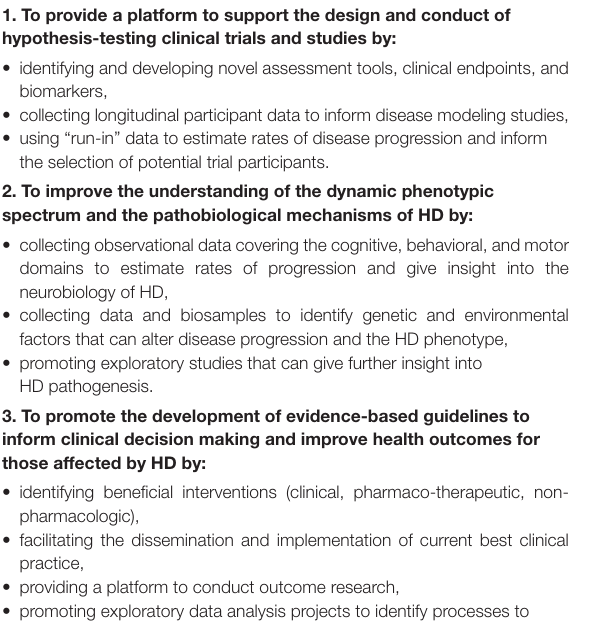
TABLE 1 | Objectives of the Enroll-HD observational